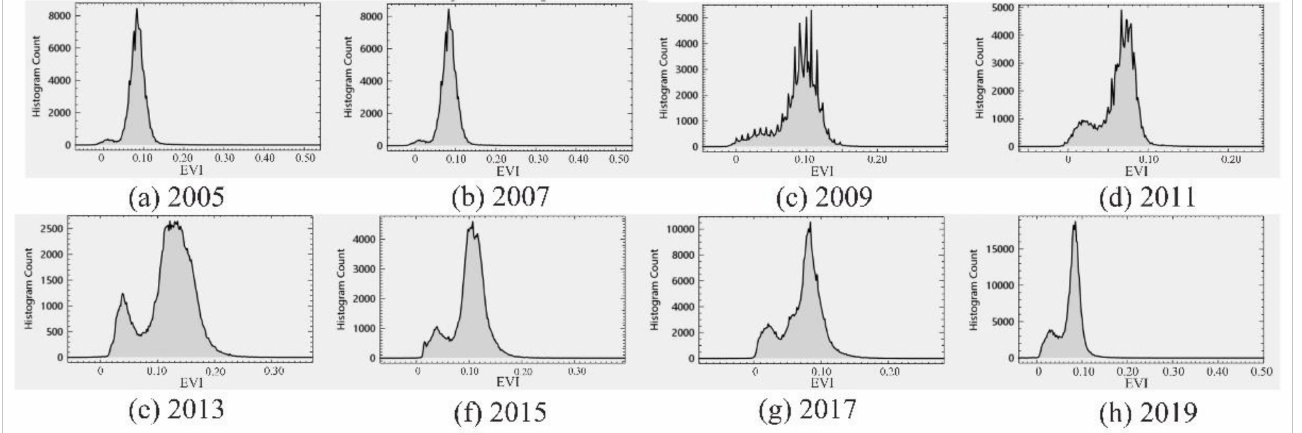
Figure A1. EVI histogram. ( a ) EVI histogram in 2005 ( b ) EVI histogram in 2007 ( c ) EVI histogram in 2009 ( d ) EVI histogram in 2011 ( e ) EVI histogram in 2013 ( f ) EVI histogram in 2015 ( g ) EVI histogram in 2017 ( h ) EVI histogram in